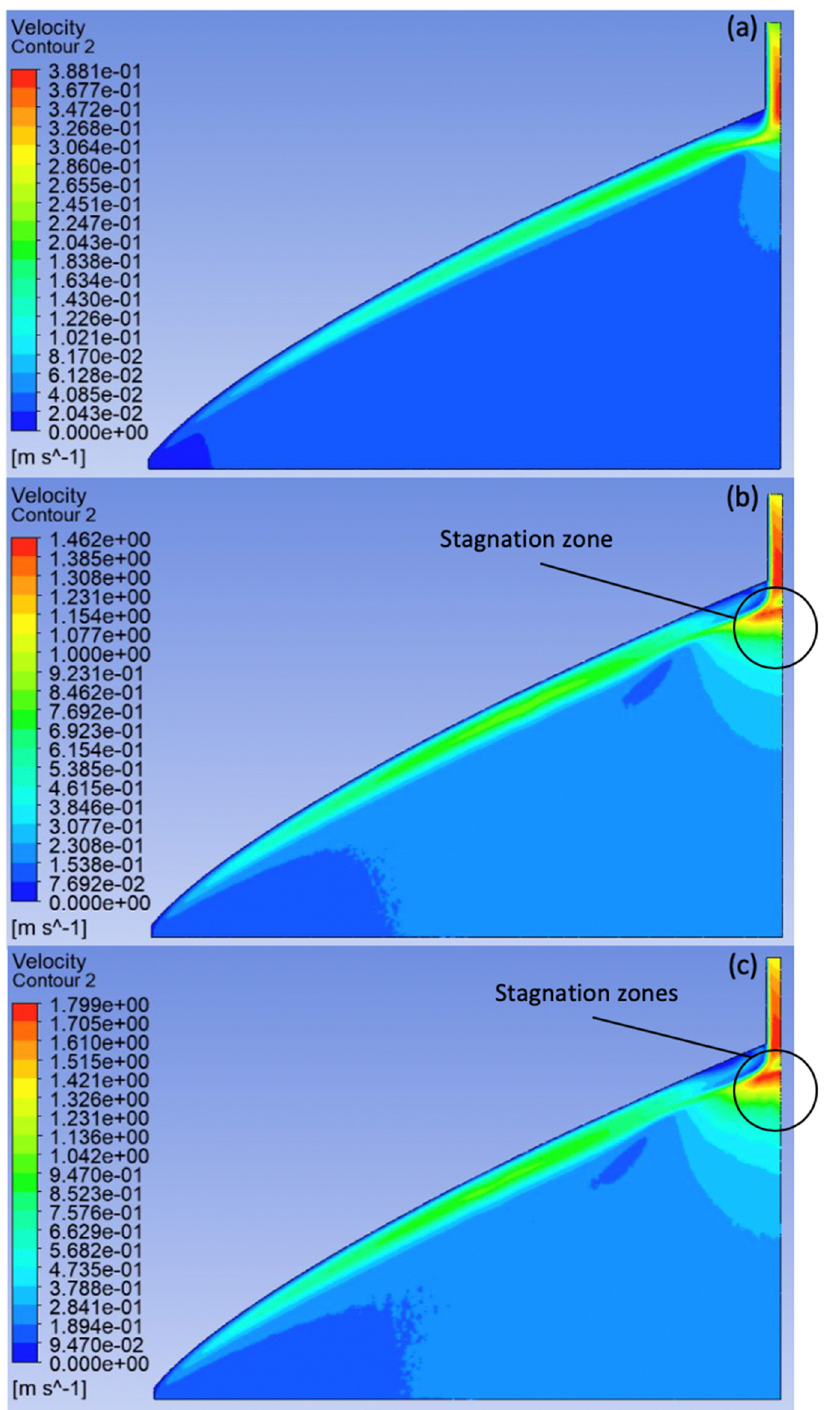
. m 1 = 0.011488 kg/s,